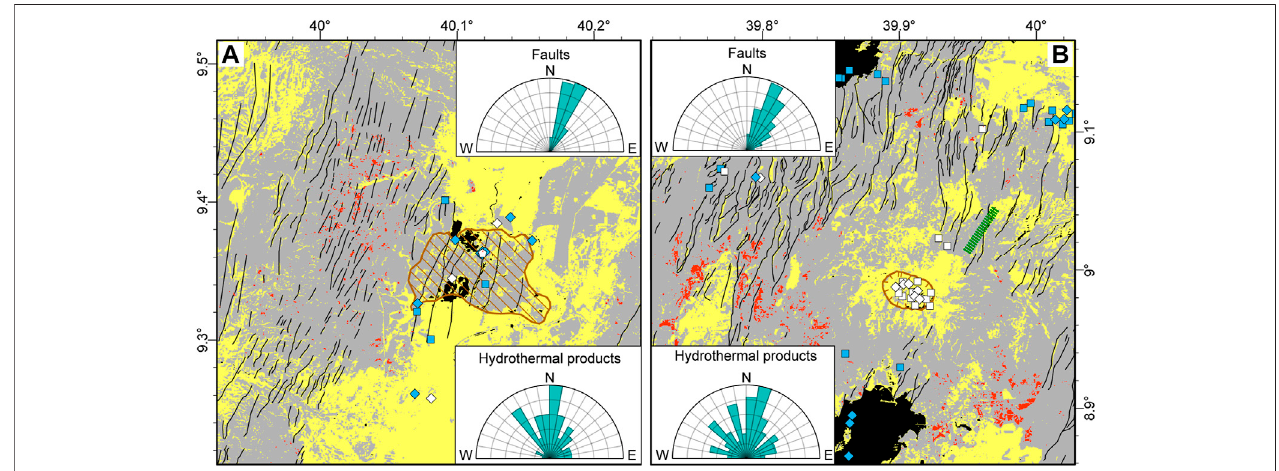
FIGURE 6 | Three classes classi fi cation maps. (A) DVC (B) Fentale volcano (legend see Figure 5C ) In both maps are reported the hydrothermal feature of the compileddatabase and intheFentale area (B) ingreenisreports alsothelocalizationofthe2015dikeintrusion.Foreach areaarereportedtherosediagrams(ontheleft for DVC and on the right for Fentale) that display the orientation of hydrothermal deposits in red and fault orientation in blue. To obtain the hydrothermal deposits, we simpli fi ed the polygon that represent these deposits and with ArcGIS we have calculated their elongation.